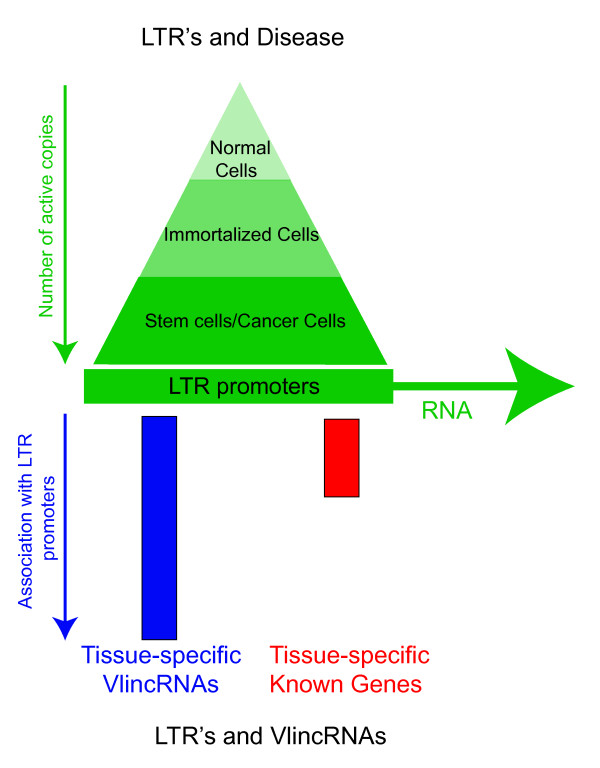
Schematic diagram of two-dimensions of endogenous LTR promoter activity: gradient of activation in malignant/pluripotent state and preferential association with tissue-specific vlincRNAs.